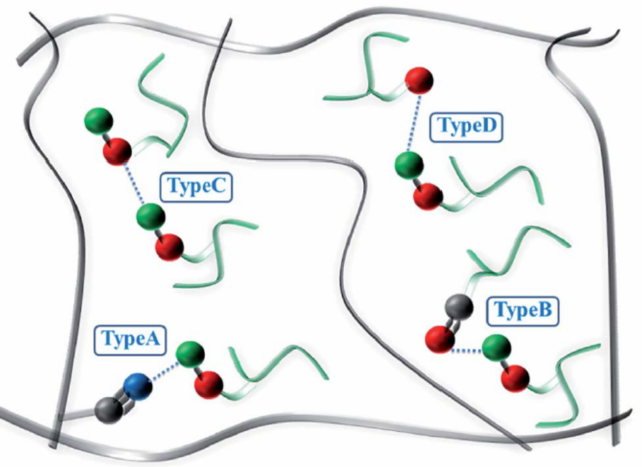
Figure 9. H-bond network in the AO-70/NBR rubber composites, (black thick lines, green short lines and blue dashed lines represent NBR polymer chains, AO-70 small molecules, and H-bonds, respectively. The black, blue, green and red balls represent carbon, nitrogen, hydrogen and oxygen atoms, respectively)